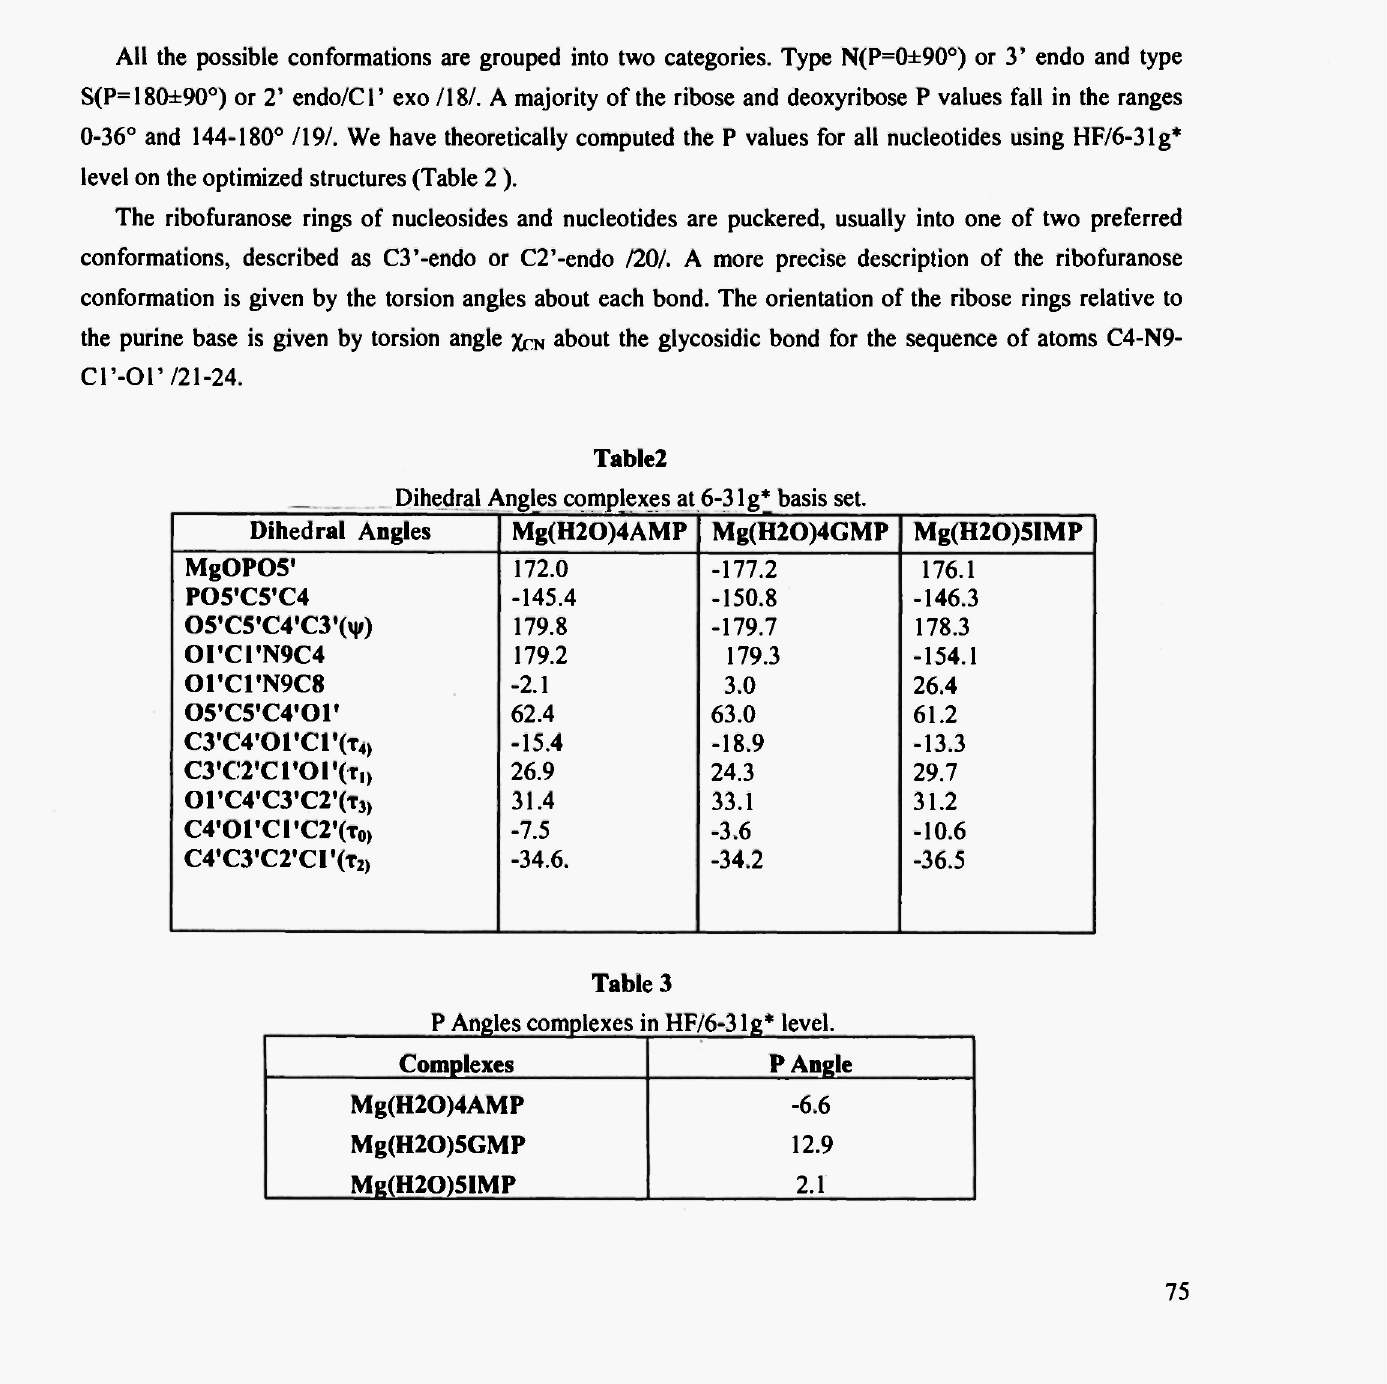
Ρ Angles complexes in HF/6-31g*